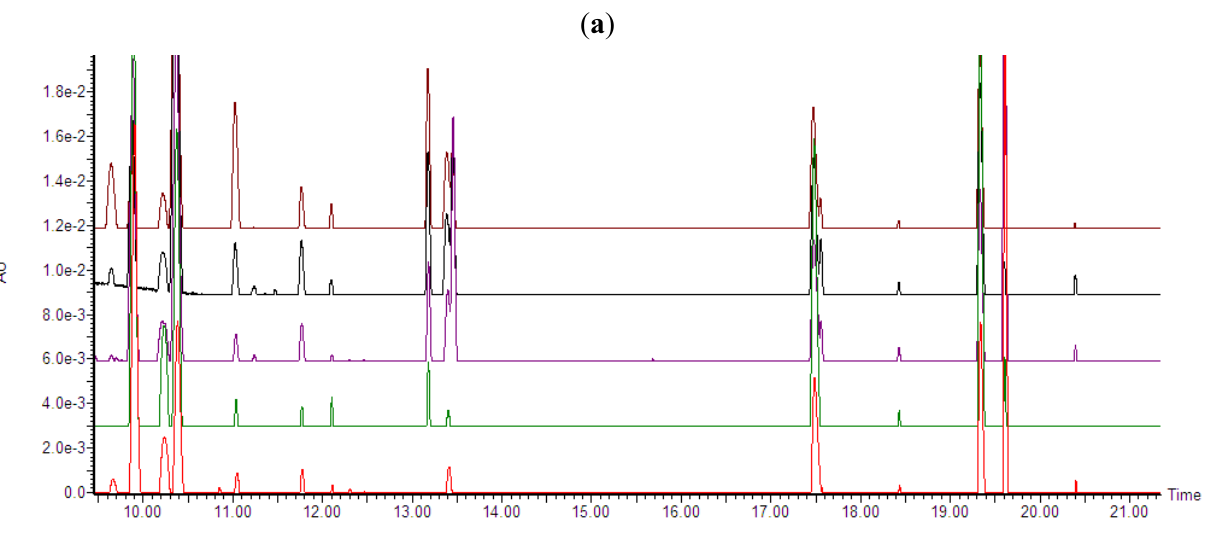
Figure 1. ( a ) UPLC-PDA chromatograms (photodiode array range: 200–500 nm) showing treatment-related variations (Concentration study). Dispersive liquid-liquid microextraction (DLLME) samples of tobacco cells treated with different ergosterol concentrations (from bottom to top: 0, 50, 150, 300 and 1000 nM) and incubated for 18 h. ( b ) UPLC-PDA chromatograms (photodiode array range: 200–500 nm) showing time-related variations. DLLME extracts of tobacco cells treated with 300 nM ergosterol and incubated for different time period (from bottom to top: 0, 6, 12, 18 and 24 h NT) and the top last chromatogram is a non-treated sample incubated for 24 h (24 h